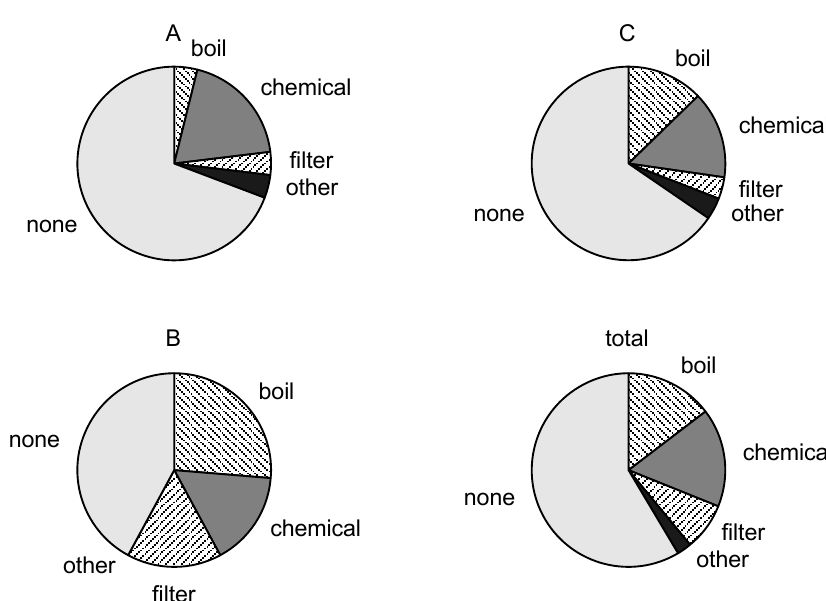
Figure 9. Self-reported water treatment practices from 50 households in each of the three communities. Researchers asked subjects, “What, if anything, do you use to treat your water?” in the vernacular. The majority of the population in all of the villages (59%) does not routinely use any water treatment.